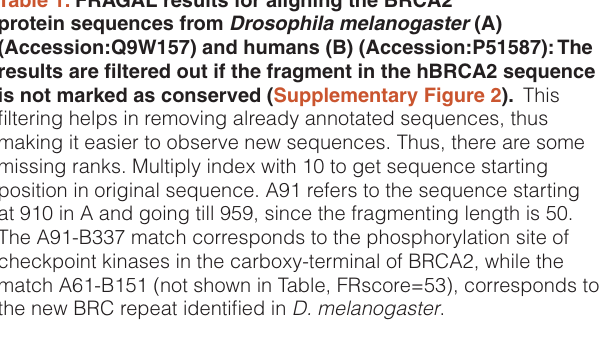
Table 1. FRAGAL results for aligning the BRCA2 protein sequences from Drosophila melanogaster